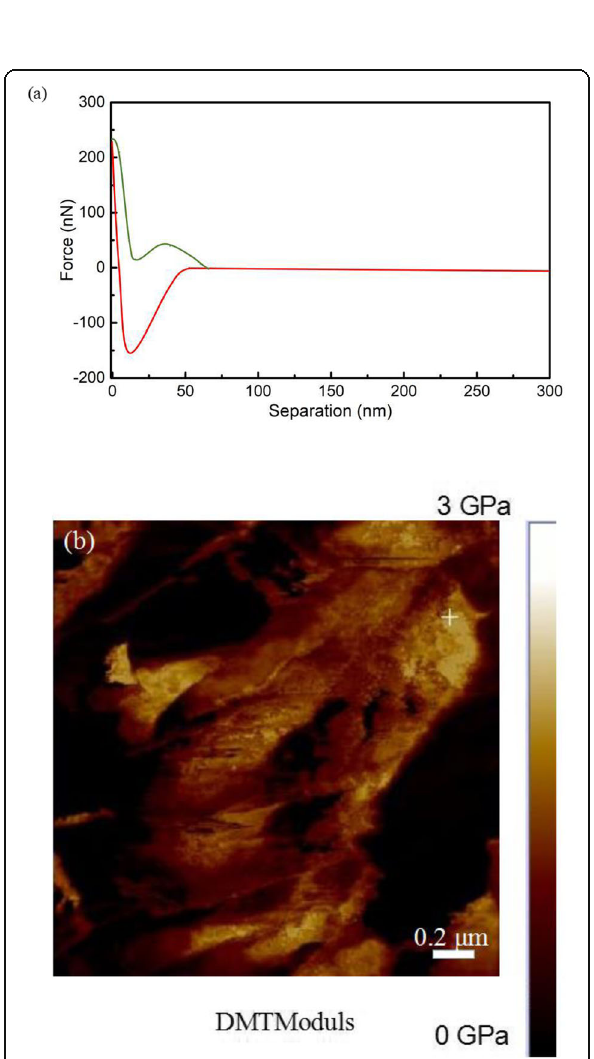
Fig. 9 a AFM force-displacement curve of graphene dendrites. b AFM DMT Modulus image of Young ’ s modulus of graphene